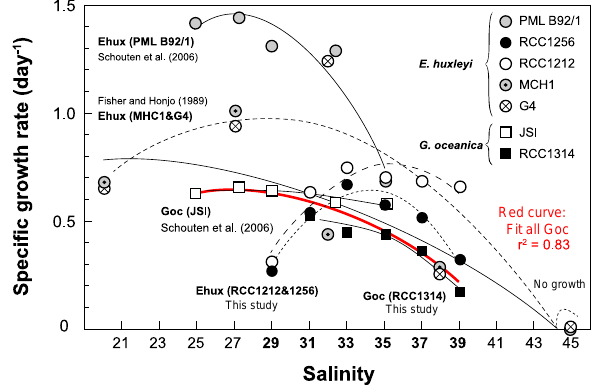
Figure 7. Compilation of previously published data documenting the variations of the specific growth rates of coccolithophores with salinity, and data of the present study shown on Fig. 2. The source for previous studies is inset. It is apparent that growth rates dimin- ish with increasing salinity with a large variability in the response according to the considered strain, especially for E. huxleyi . By con- trast, data for G. oceanica seem to be in good agreement between studies and strains (red curve), disregarding the fact that no growth was achieved by RCC1314 at Sal29 in our study. Overall, this graph highlights the euryhaline nature of open ocean microalgae that typ- ifies the ecology of the coccolithophores thriving in the oceans and maintained in the laboratory under salinities nearing